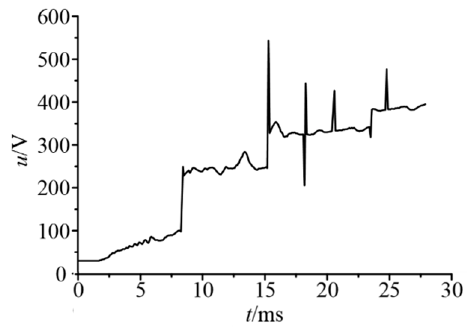
Figure 12. Arc voltage curve (DC 1500 V).